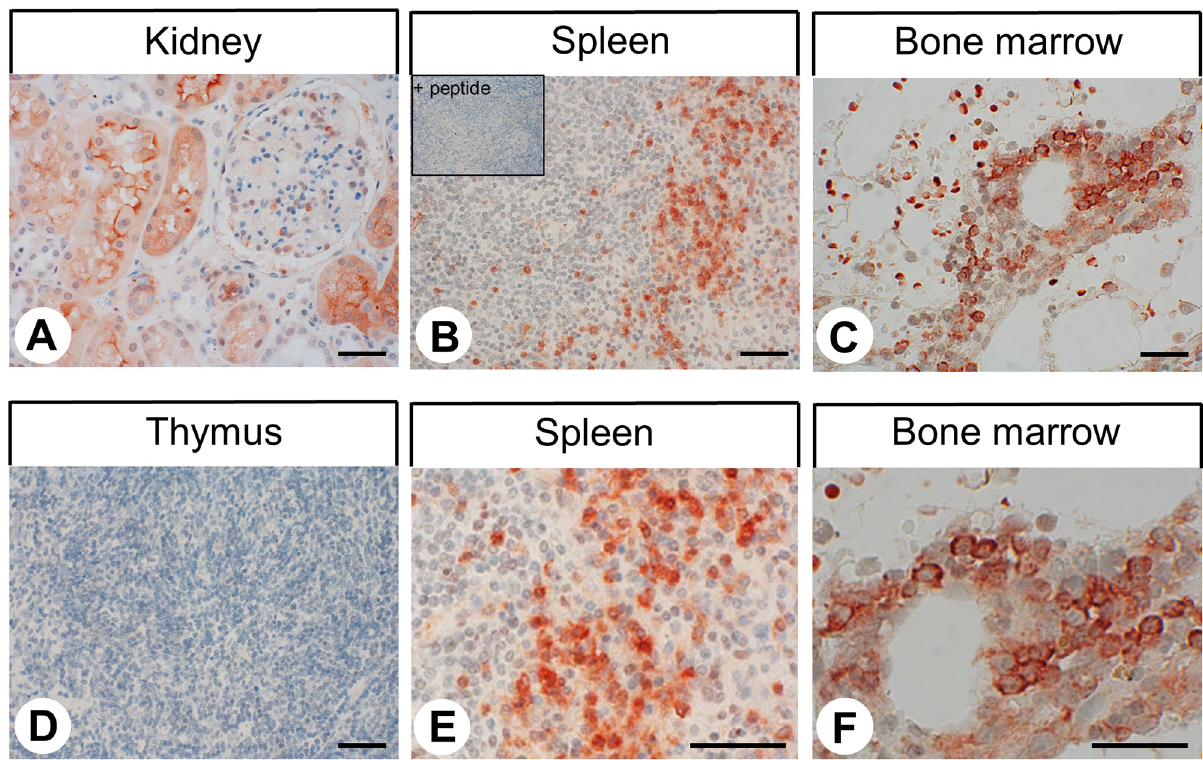
Fig 4. Immunohistochemical detection of C5aR1 localisation in non-neoplastic human tissues (II). Immunohistochemical staining (red-brown colour), counterstaining with haematoxylin. Scale bar: 50 μ m (A, D, C, E), 30 μ m (D, F). Inset in (B): for adsorption control, the anti-C5aR1 antibody {5227} was incubated with 10 μ g/ml of the peptide used for immunisations. (E and F) enlarged sections of (B and